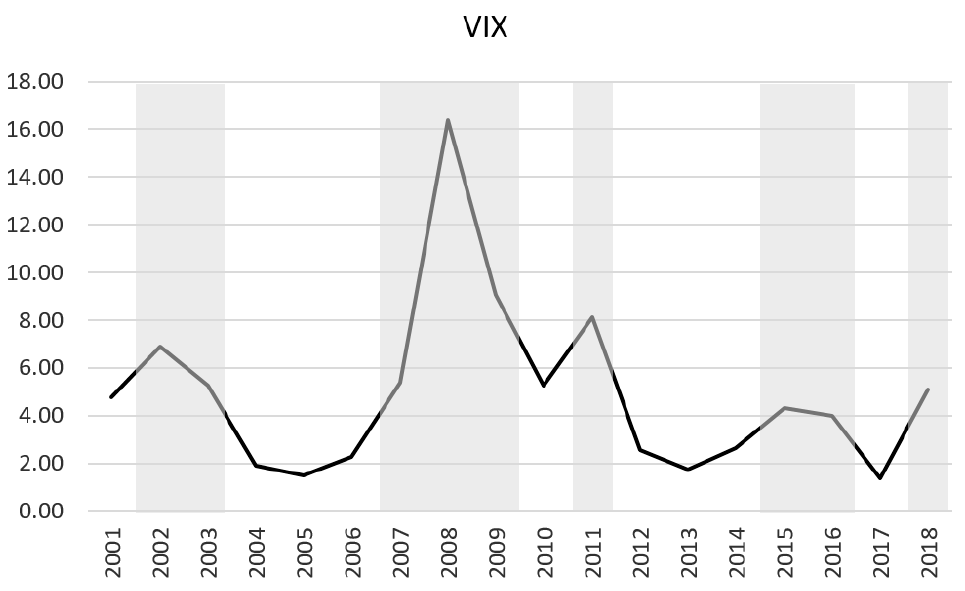
Figure 1. Time series of VIX index.